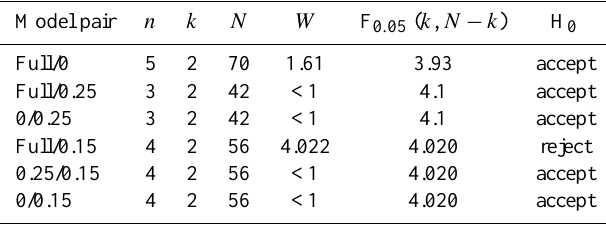
Table 2. The Levene test statistic, W , applied to test homogeneity of variances in spherical albedo differences between two groups of scattering phase function models for each set of pixels. In the table, the two phase function models are represented for each set of pixels by their assumed distortion values, referred to as Model pair; the total number of pixels used in each test is n . The null hypothesis is given by H 0 , which is either rejected or accepted; k is the number of samples; N is the total number of observations in the two samples; and F 0 . 05 ( k , N − k ) is the value of the tabulated upper critical value at the 5% significance level composed of k and N − k degrees of freedom.